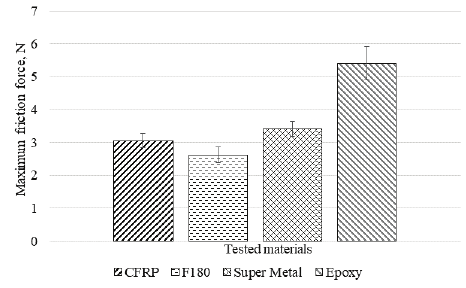
Figure 4. Maximum friction